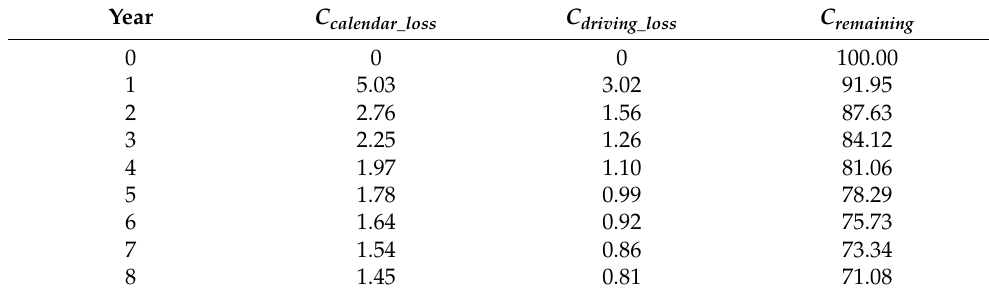
Figure 19. Temperature, initial daily SOC value and the number of driving cycles in a year. A time period of 8 years was considered to evaluate the capacity loss for the calendar and driving cycle. A cell charging is done when the voltage is below 3.1 V assessed as a SOC lower than 30%. After the charging period, the upper voltage cut-off of the cell is 4.12 V (100% SOC). The number of daily WLTP driving cycles was distributed as shown in Table 12. The total capacity loss was then computed for an 8-year time frame, and the annual percentages are shown in Table 13. Table 13. Typical yearly vehicle